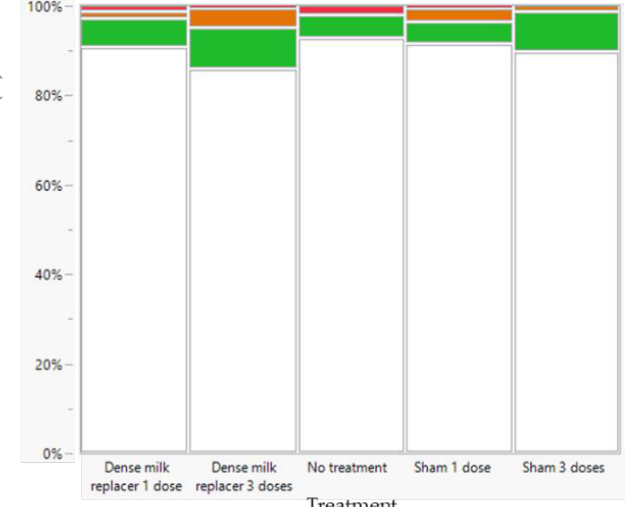
Figure 7. Distribution of skin lesion (SL) scores per treatment at Farm B (low perinatal management) of the selected low birth weight piglets ( n = 150) per treatment (dense milk replacer [DMR] one dose, DMR three doses, no treatment, sham one dose, sham three doses). The following scoring system was applied: 0: no lesions (white); 1: <5 superficial lesions (skin unbroken) (green); 2: 5–10 superficial lesions or <5 deep lesions (skin broken and evidence of haemorrhage) (orange); 3: >10 superficial lesions or >5 deep lesions (red).